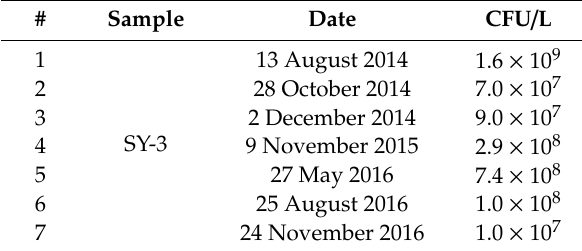
Table 1. Colony counts of culturable thermophilic